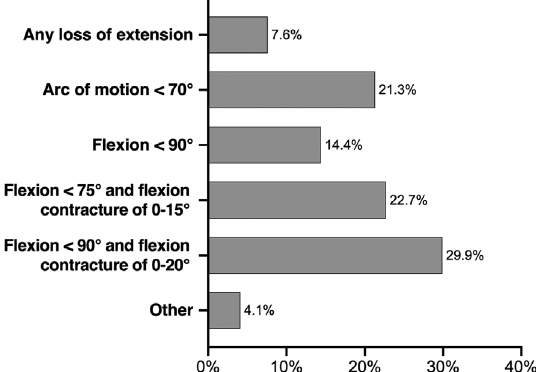
Figure 4. Results of the survey question: How do you de fi ne stiffness following Total Knee Arthroplasty?